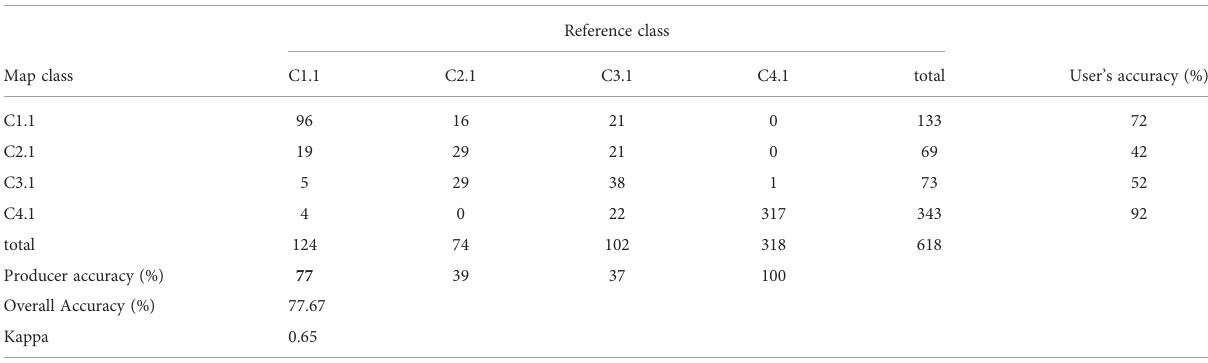
TABLE 3 Confusion matrix obtained with KNN supervised classi fi cation, for different seed criteria. LAI